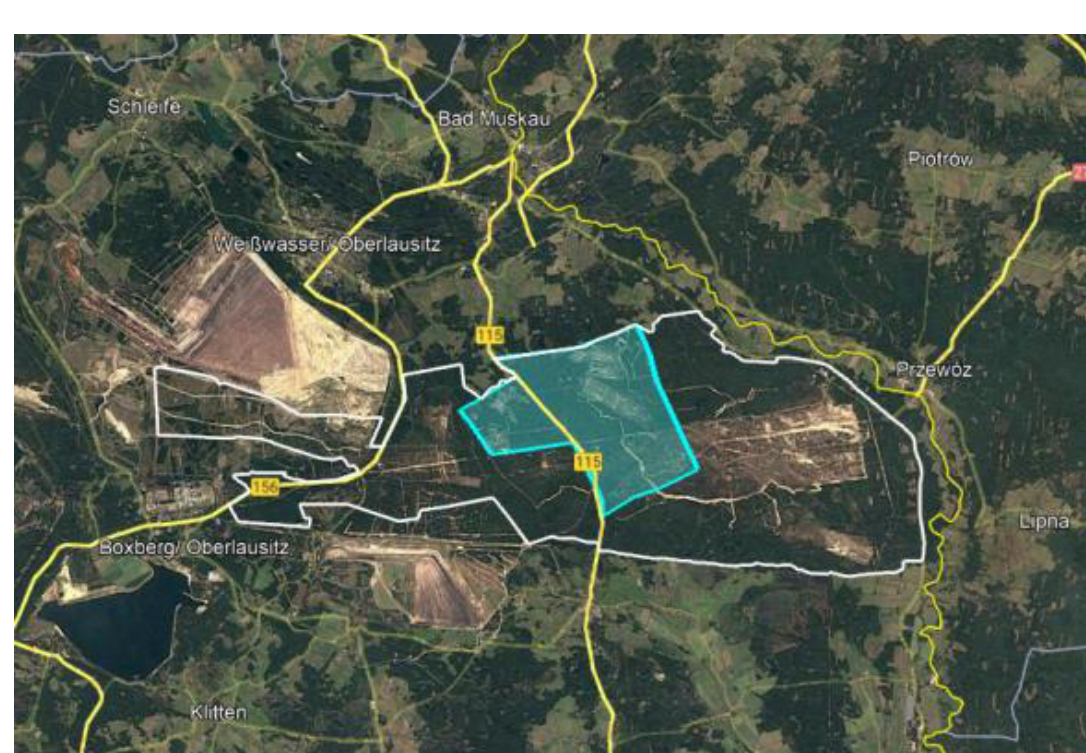
Figure 6. The inner and outer test area for red edge